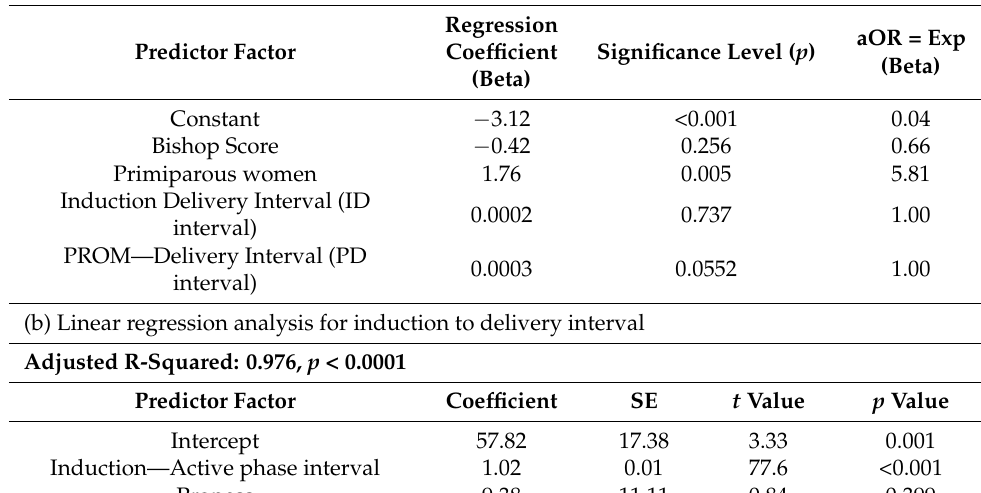
Table 8. Logistic and linear regression analysis. (a) Logistic regressions analysis for risk of operative